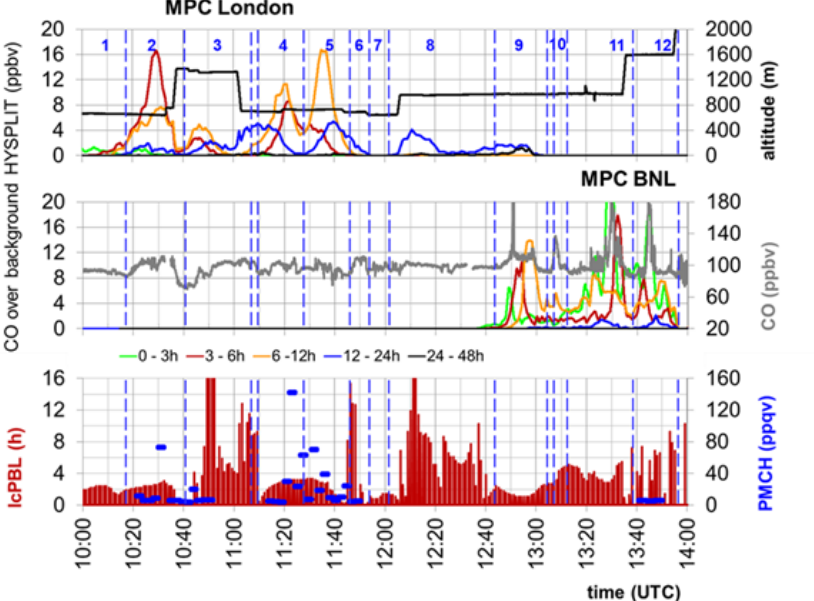
Figure 20. Detail of the MPC outflow of London (B-01 to B-09) and BNL/Ruhr (B-09 to B-12) probed with HALO along the E-EU-08 flight track. Numbering in blue corresponds with the classification in Fig. 13 (“B-0” is omitted for clarity). The position of the plumes is also indi- cated by the blue lines. Dispersion of CO emissions of target MPCs and the transport time of the air mass calculated by HYSPLIT are depicted in the middle panel. The last contact with the PBL (lcPBL) calculated using FLEXTRA is also shown. Elevated perfluoromethylcyclohexane (PMCH) mixing ratios were measured for B-02, B-04, and B-05.